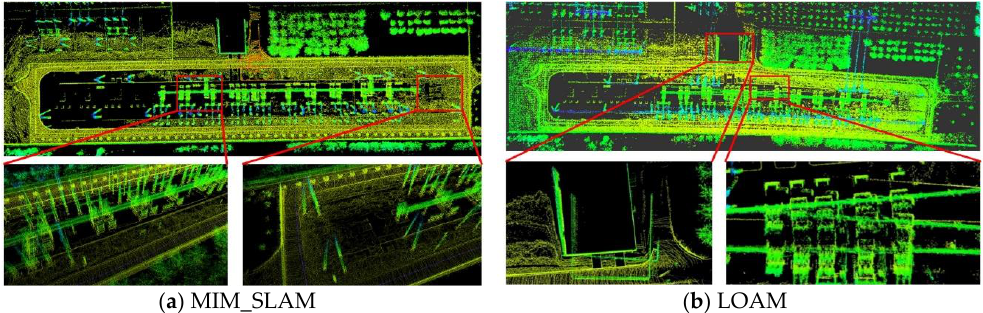
Figure 7. The point cloud maps established by the MIM_SLAM and the LOAM [12] algorithms.